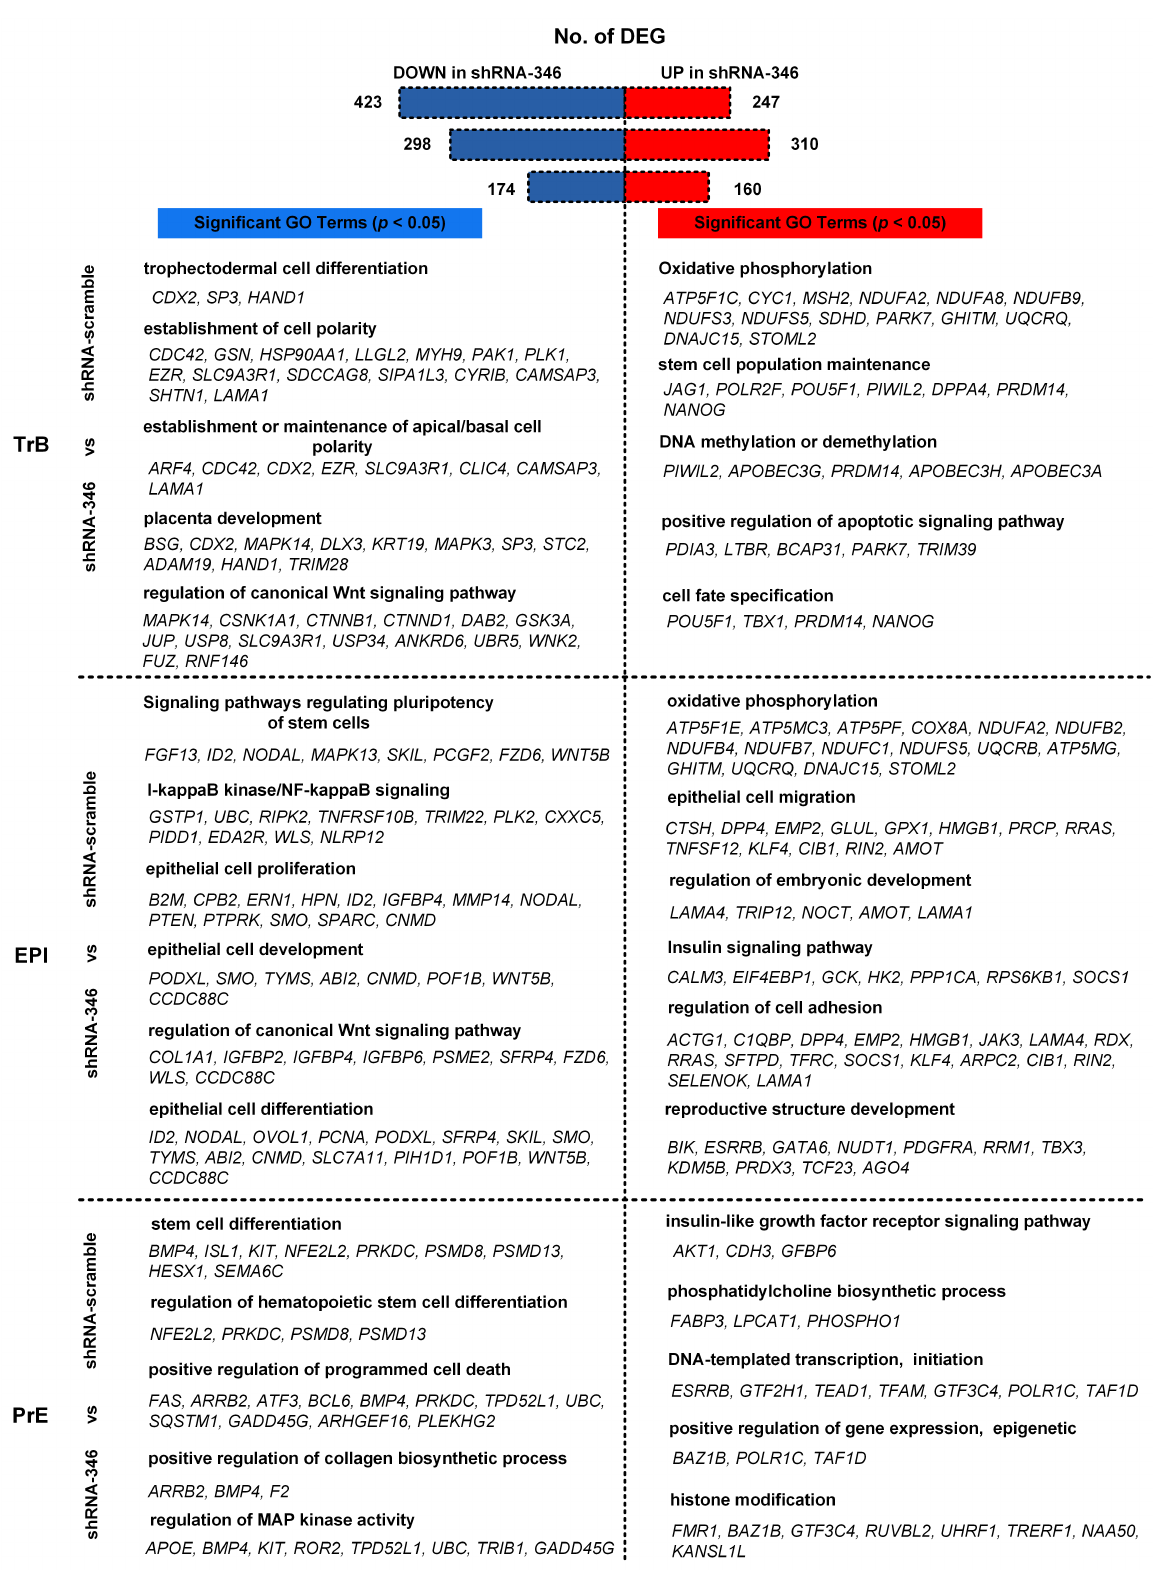
Figure 5. Differentially expressed genes (DEGs) and their corresponding gene ontology (GO) terms in TrB, EPI, and PrE from shRNA-346- or shRNA-scramble-treated embryos. DEGs were identified with function of FindMarkers in Seurat, test.use with DEseq2. p -value < 0.05, min.pct = 0.1. Significant upregulated and downregulated genes were used to identify enriched GO terms with the Metascape website (https://metascape.org/, accessed on 28 September